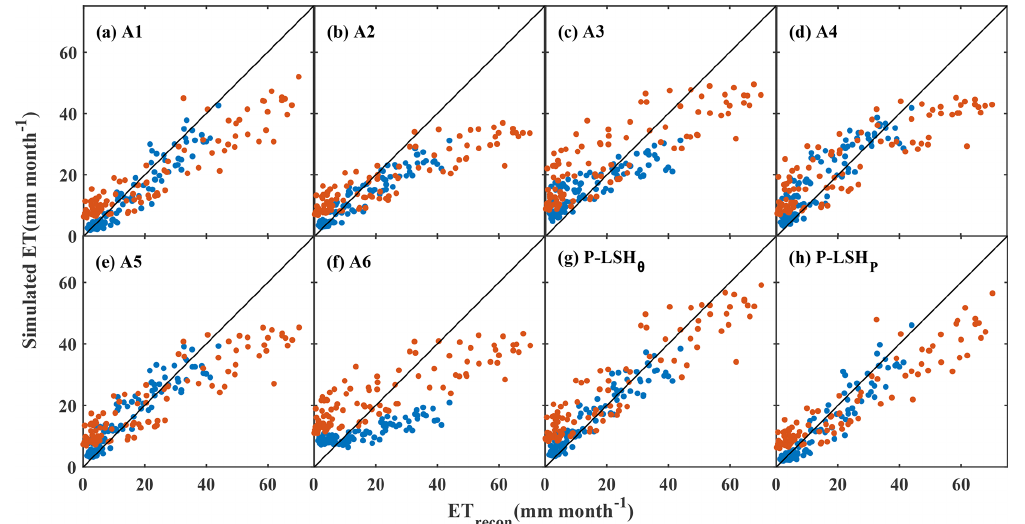
Figure 3. Simulated ET derived from the six existing coupling algorithms and the two improved algorithms versus the recon- structed ET (ET recon ). The A1–A6, P-LSH θ , and P-LSH P are the coupling algorithms listed in Table 2. The blue dots represent results for Qaidam Basin and the red for Qiangtang Plateau.